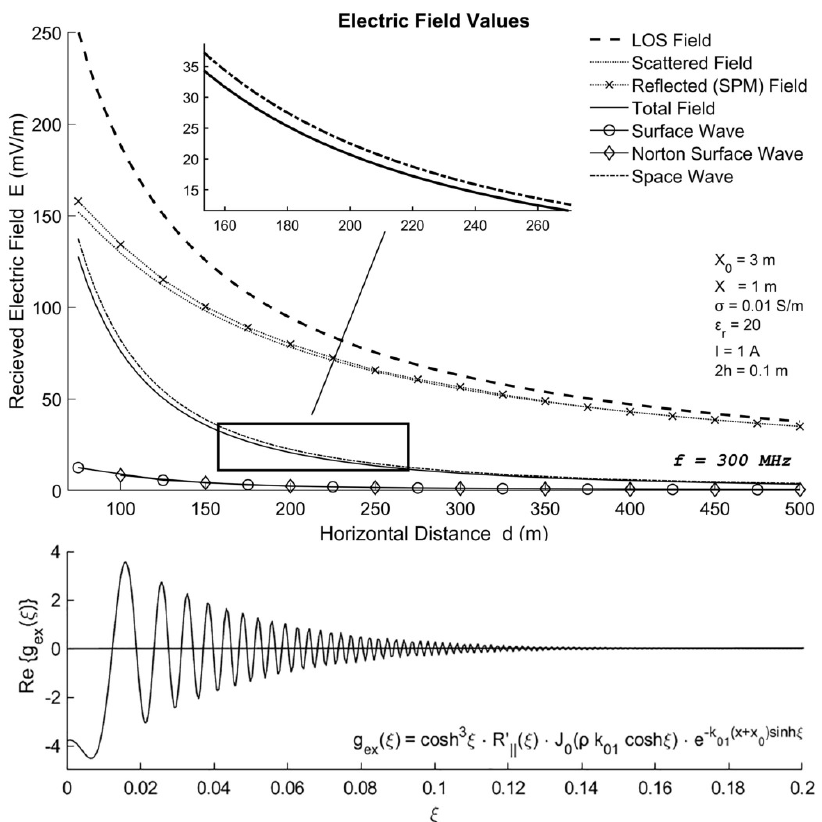
Figure 4. Numerical evaluation of the EM field at the VHF/UHF band; top: comparisons of various field types, bottom: integrand behavior of